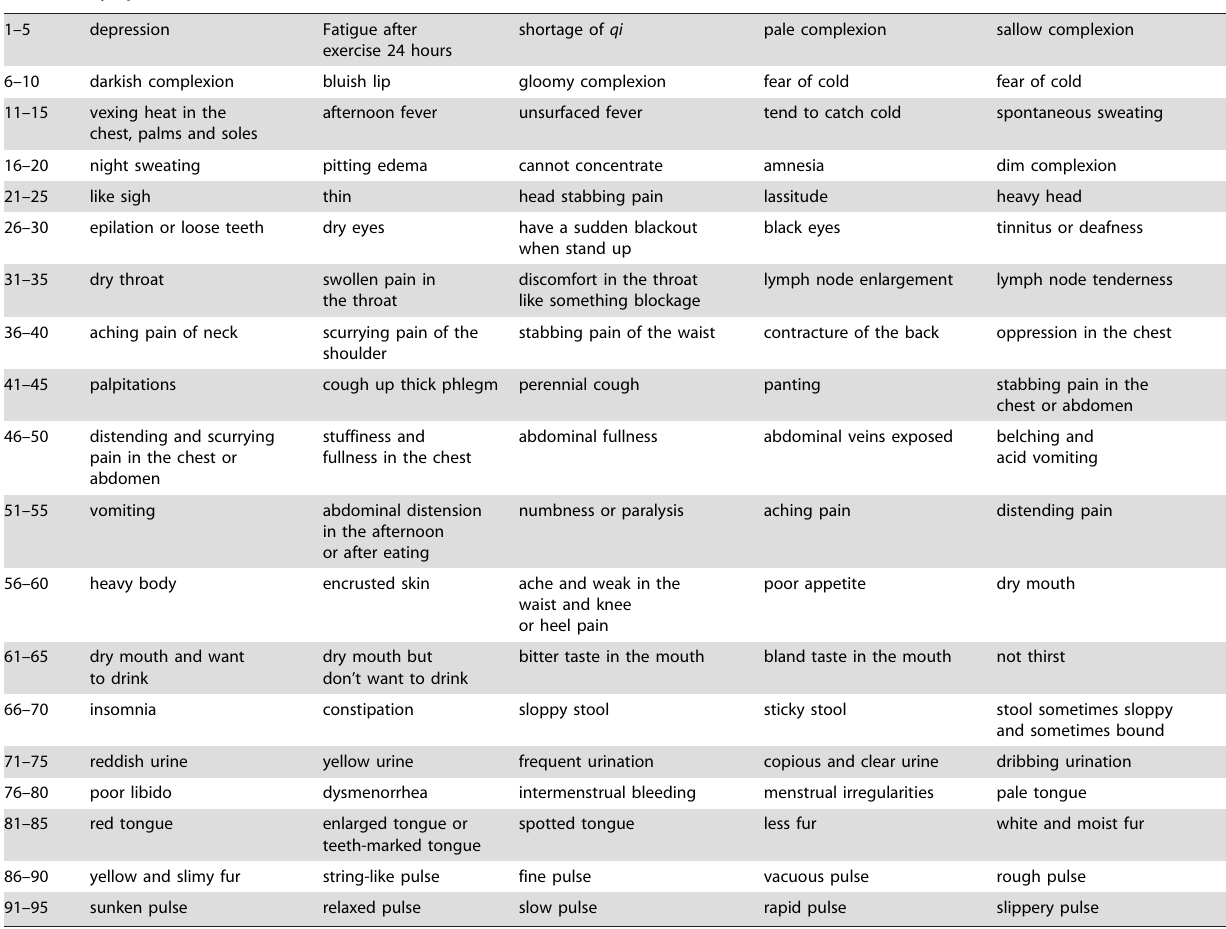
Table 1. Set of symptom of CF in